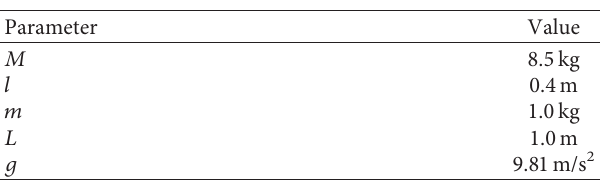
Table 1: Simulation parameters.